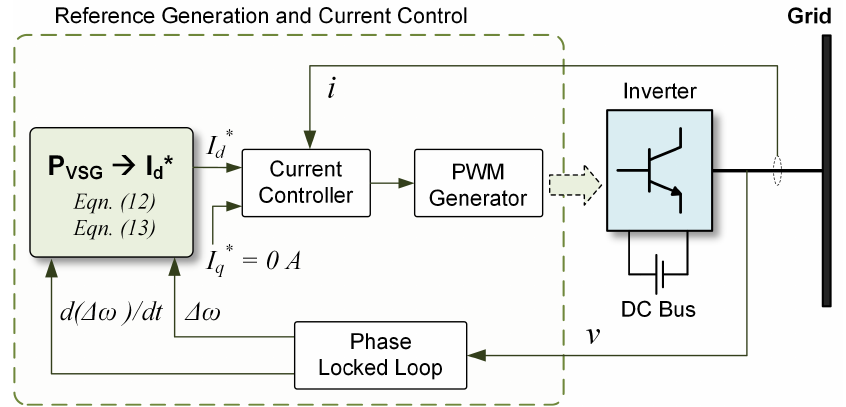
Figure 9. Virtual synchronous generator (VSG)